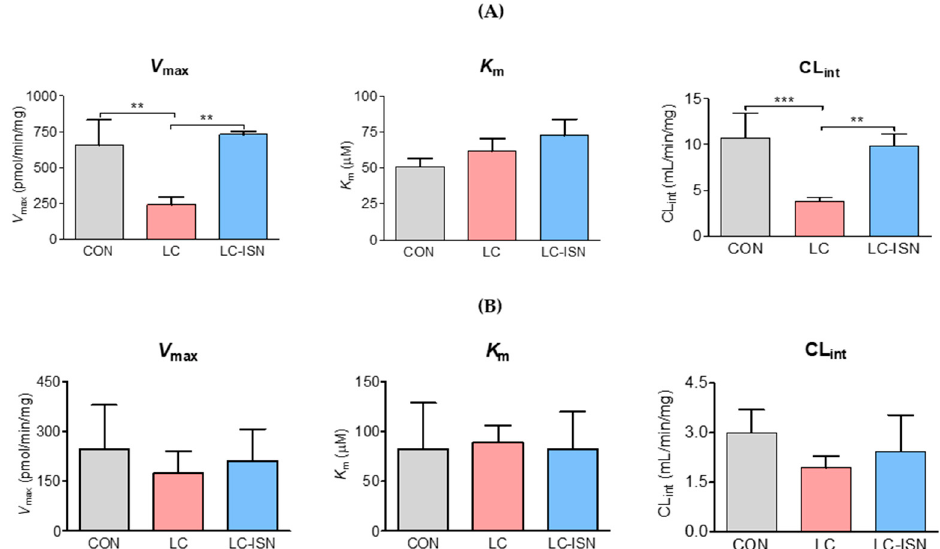
Figure 5. The mean value of V max , K m and CL int for the disappearance of tofacitinib in ( A ) hepatic ( n = 3, per group) and ( B ) intestinal microsomes ( n = 3, per group) obtained from CON, LC and LC-ISN rats. This experiment was repeated thrice. Bars represent standard deviations. CON, control; LC, liver cirrhosis induced by N -dimethylnitrosamine; LC-ISN, LC with treatment of isosakuranetin; V max , maximum velocity; K m , the concentration of tofacitinib at one-half of V max ; CL int , intrinsic clearance. ** p < 0.01 and *** p < 0.001.